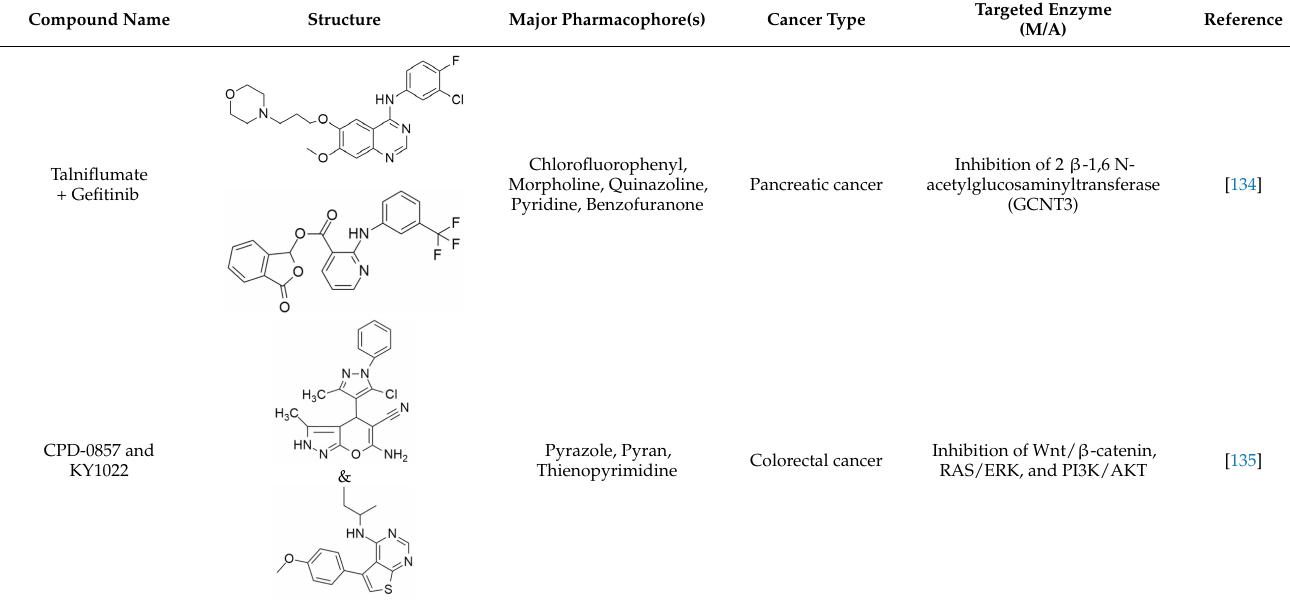
Table 4. Mixed heterocyclic small-molecule RAS inhibitors.